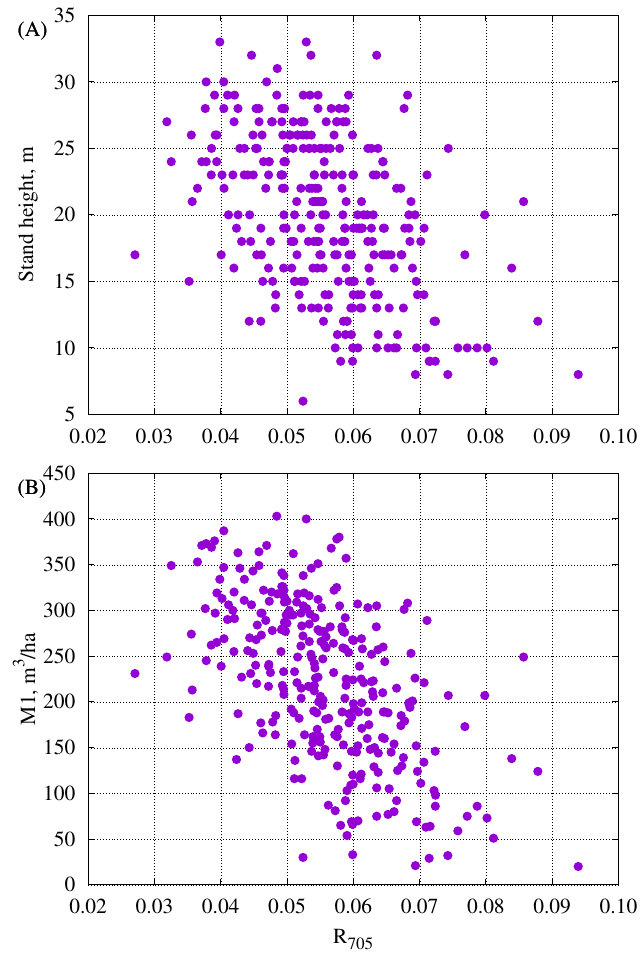
Figure 7. Single band reflectance factor at red-edge spectral region R 705 in relation to: ( A ) stand height H ( ρ = − 0.47, p < 0.001); and ( B ) stemwood volume of dominant layer M1 ( ρ = − 0.57, p <